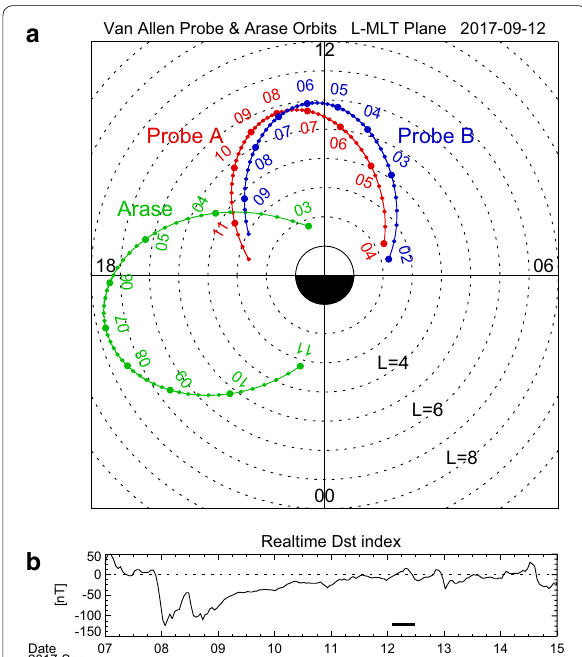
Fig. 1 a Orbits of Van Allen Probe A for 04:00–11:30 UT (red curve), Van Allen Probe B for 02:00–09:30 UT (blue curve), and Arase for 03:00–11:00 UT (green curve) on 12 September 2017 in the L -MLT plane. b The real-time Dst index for 7–14 September 2017. A horizontal bar represents the time interval of 02:00–11:30 UT on 12 September 2017 which covers the orbital segments of Probe A, Probe B, and Arase shown in